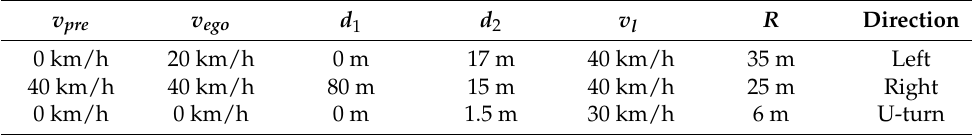
Figure 6. Turn left test result: ( a ) rear track image; ( b ) front and rear vehicle speed.